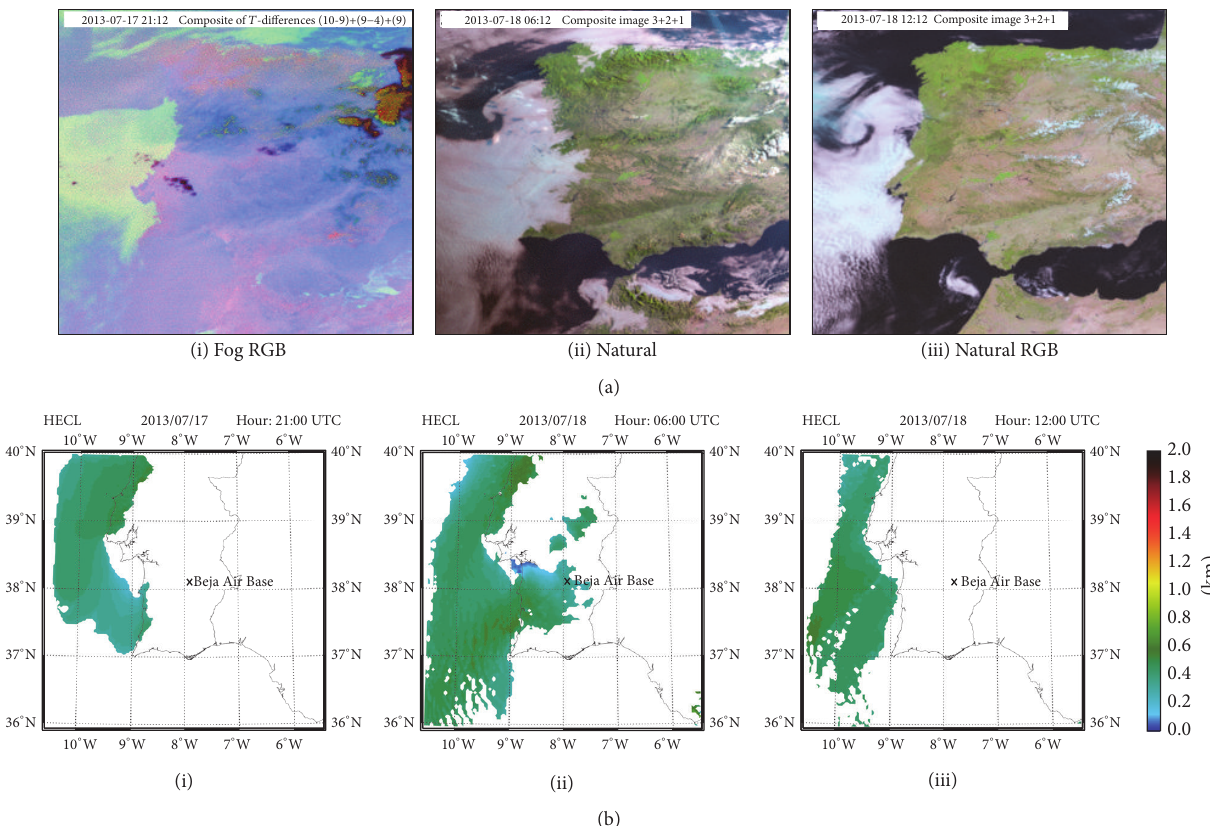
Figure 12: Sequence of satellite images in 17/07/2013 at 21:12 UTC and in 18/07/2013 at 06:12 and 12:12 UTC; (b) simulation of explicit cloud top height from the surface in 17/07/2013 at 21:00 UTC and in 18/07/2013 at 06:00 and 12:00 UTC in D1 domain.